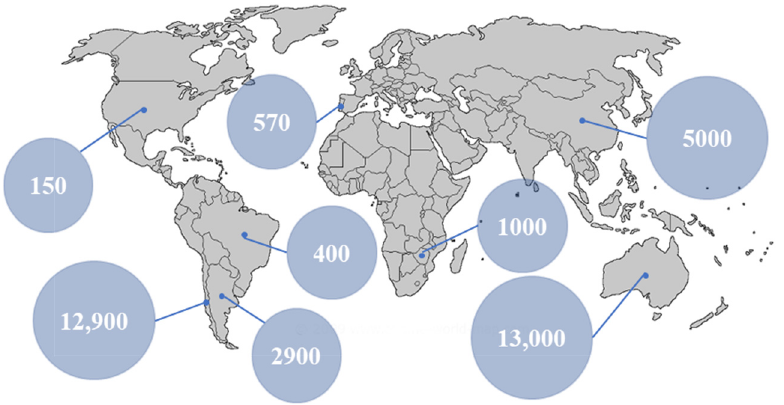
Figure 1. World production of lithium in 2017 calculated in ton/year. Reprinted based on the open access license [11].